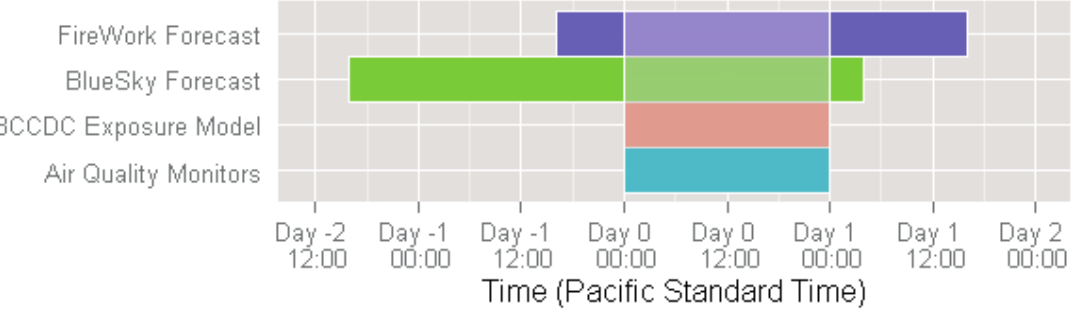
Figure 3. Exposure metrics timeline showing data used to calculate 24-h average exposure levels for Day